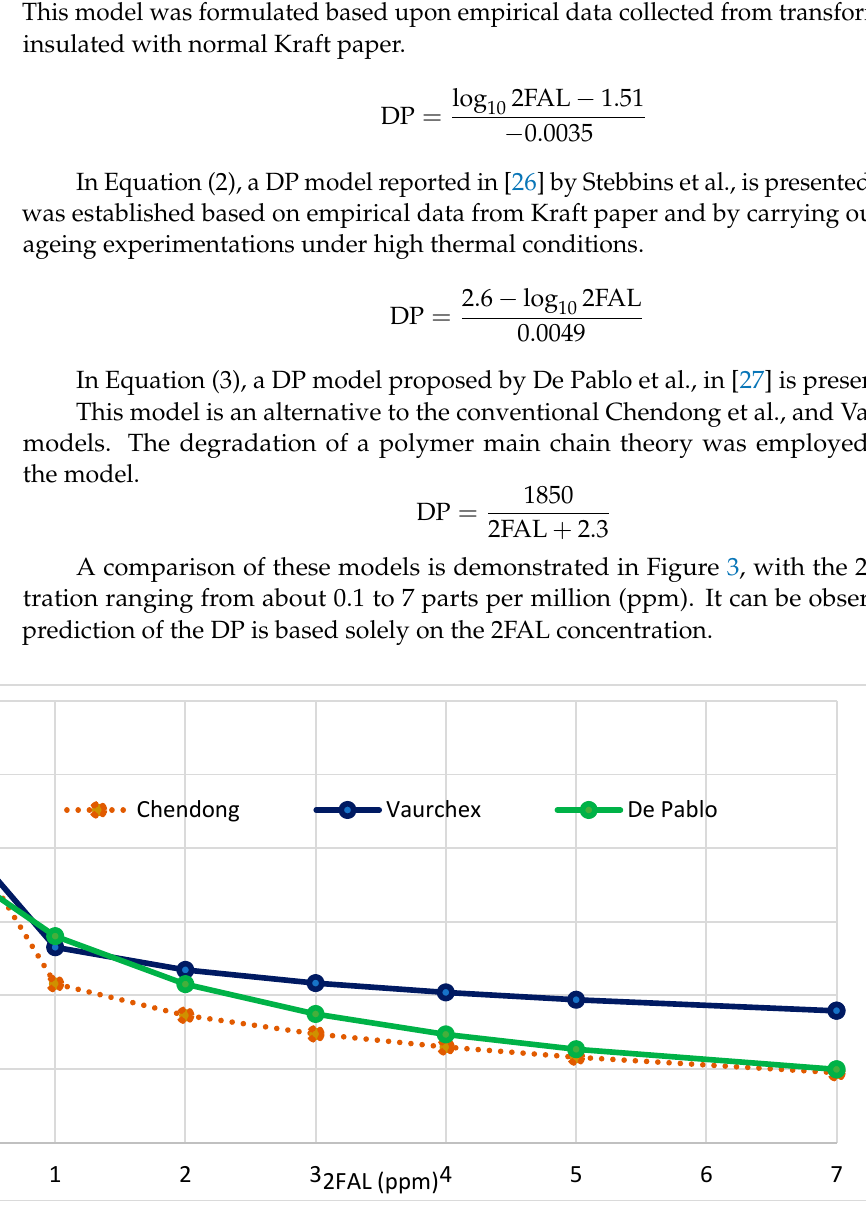
Figure 3. Model comparison: DP vs. 2FAL.